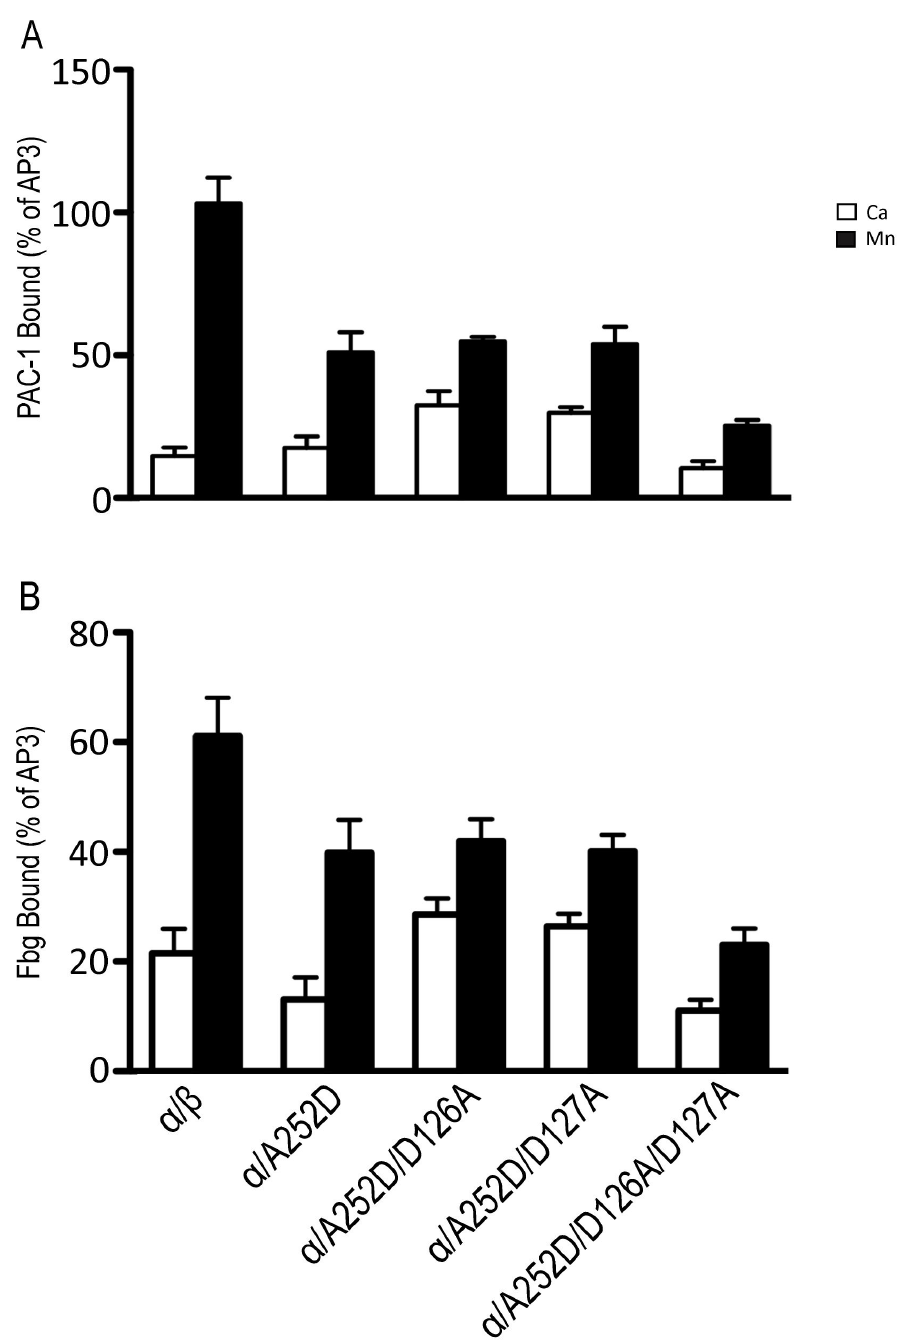
Figure 3. Soluble Ligand Binding with PAC-1 and Fibrinogen. Cells were incubated with (A) PAC-1 in the presence of 5 mM Ca 2+ or 1 mM Mn 2+ or (B) FITC-fibrinogen in the presence of 5 mM Ca 2+ or 1 mM Mn 2+ as indicated. Binding activities were determined by flow cytometry and expressed as described in Materials and Methods. Error bars are standard deviation (SD). An unpaired t-test with n=1000 for each group was conducted and showed to be statistically significant with a p-value <0.05 between WT and A252D for PAC-1 binding in Mn 2+ conditions and fibrinogen binding in both Ca 2+ and Mn 2+ conditions, between WT and A252D/D126A as well as WT and A252D/D127A for PAC-1 and fibrinogen binding in both Ca 2+ and Mn 2+ conditions, and between A252D and A252D/D126A as well as A252D and A252D/D127A for PAC-1 and fibrinogen binding in Ca 2+ conditions. However, insignificant results with a p-value >0.05 occurred between WT and A252D for PAC-1 binding in Ca 2+ conditions and between A252D and A252D/D126A as well as A252D and A252D/D127A for PAC-1 and fibrinogen binding in Mn 2+ conditions. doi: 10.1371/journal.pone.0076793.g003 PLOS ONE |